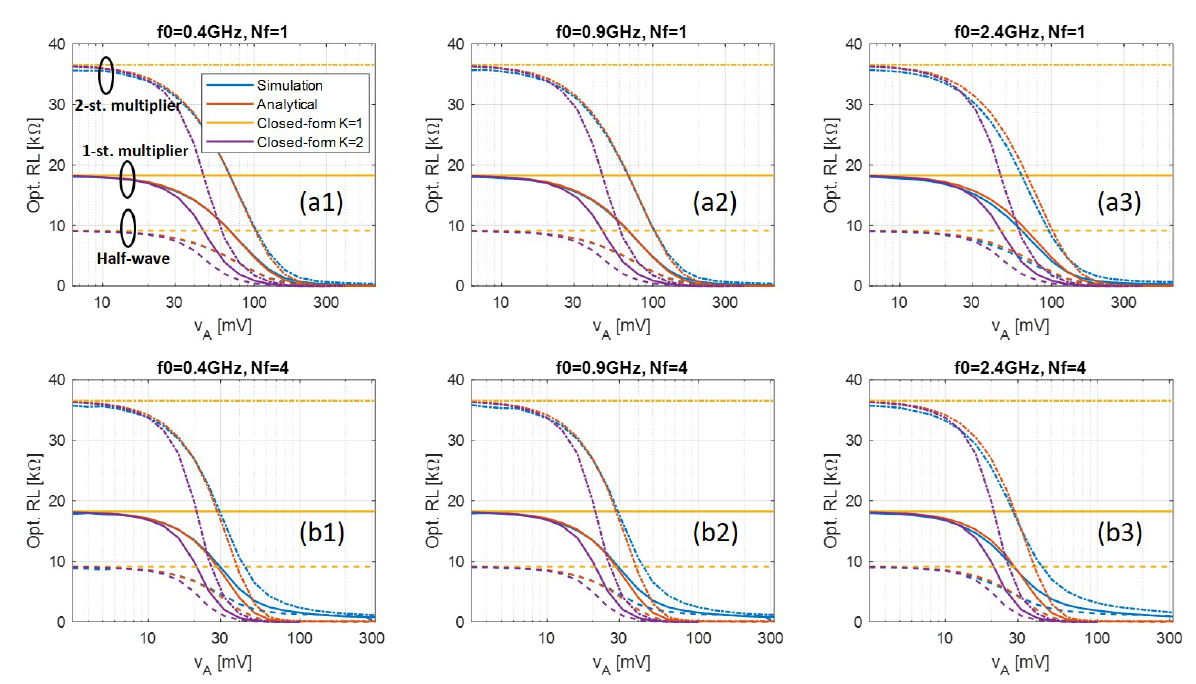
Figure 4. Optimal load calculated by transient simulation (blue), numerical solution of the analytical model (red), and closed-form solutions (yellow and purple) when ( a ) N f = 1, and ( b ) N f = 4 with ∆ f = 1 MHz, simulated with half-wave, 1-, and 2-stages voltage-multipliers using Avago HSMS285x. The results under different frequency bands ( a1 , b1 ) 400 MHz, ( a2 , b2 ) 900 MHz, and ( a3 , b3 ) 2.4 GHz are shown,